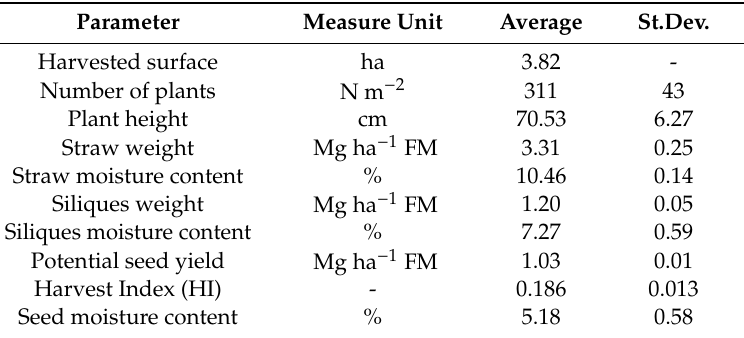
Table 3. Results of pre-harvest tests.